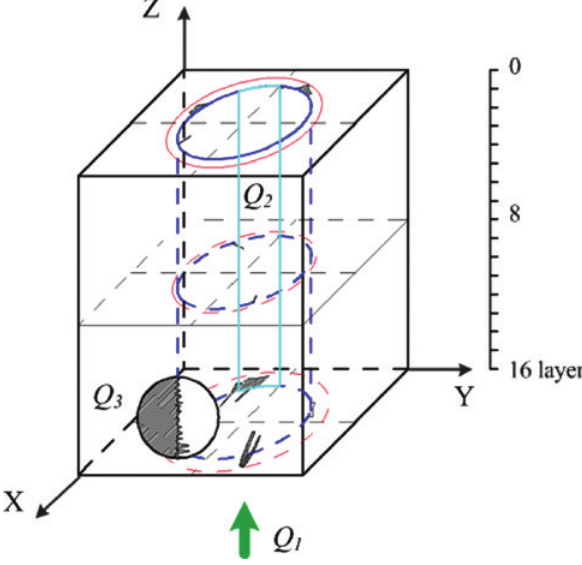
Figure 2: Diagrammatic sketch of the evaluation method of the 3D